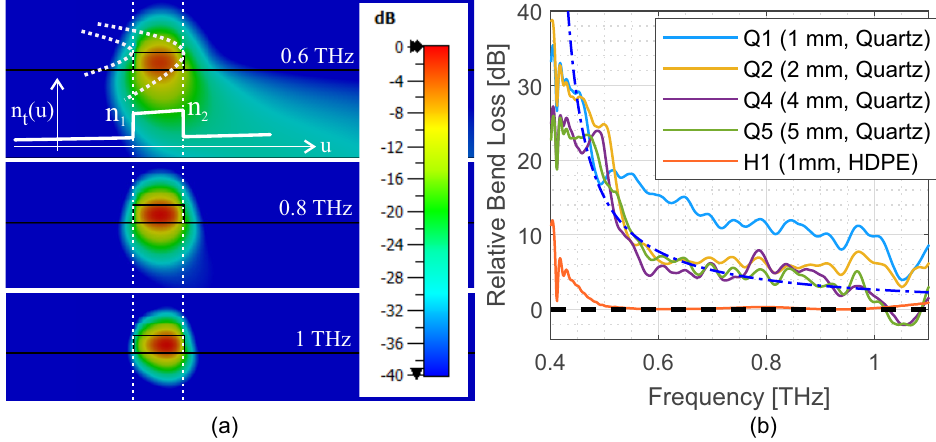
Figure 4. ( a ) Radiative losses and mode transformation at waveguide bends. The conformal- transformed refractive index n t ( u ) is plotted of a waveguide bend, with ROC = 2 mm where n 1 = 3.25 and n 2 = 3.59. ( b ) Measured losses for different curved waveguides on quartz normalized to a straight waveguide ( l WG = 19.14 mm) on HDPE. The apparent dips for Q1-5 at 1.05 THz is a measurement artefact arising due to standing waves. The blue dashed line is added to serve as a guide for the eye for